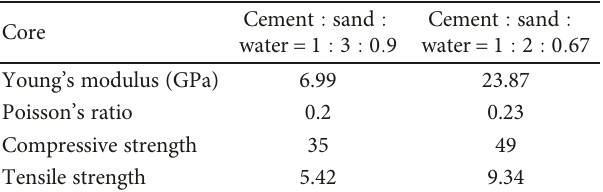
Table 2: Mechanical parameters of the